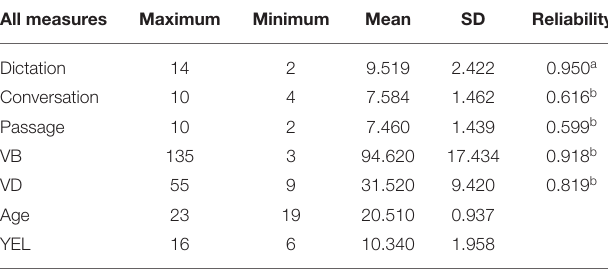
TABLE 5 | Descriptive statistics for all